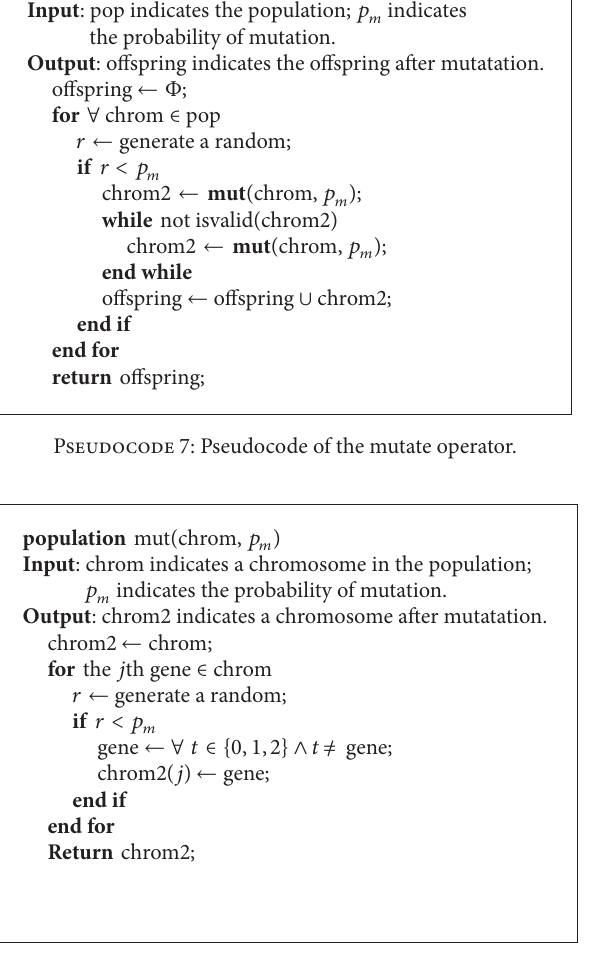
Pseudocode 8: Pseudocode of the mut